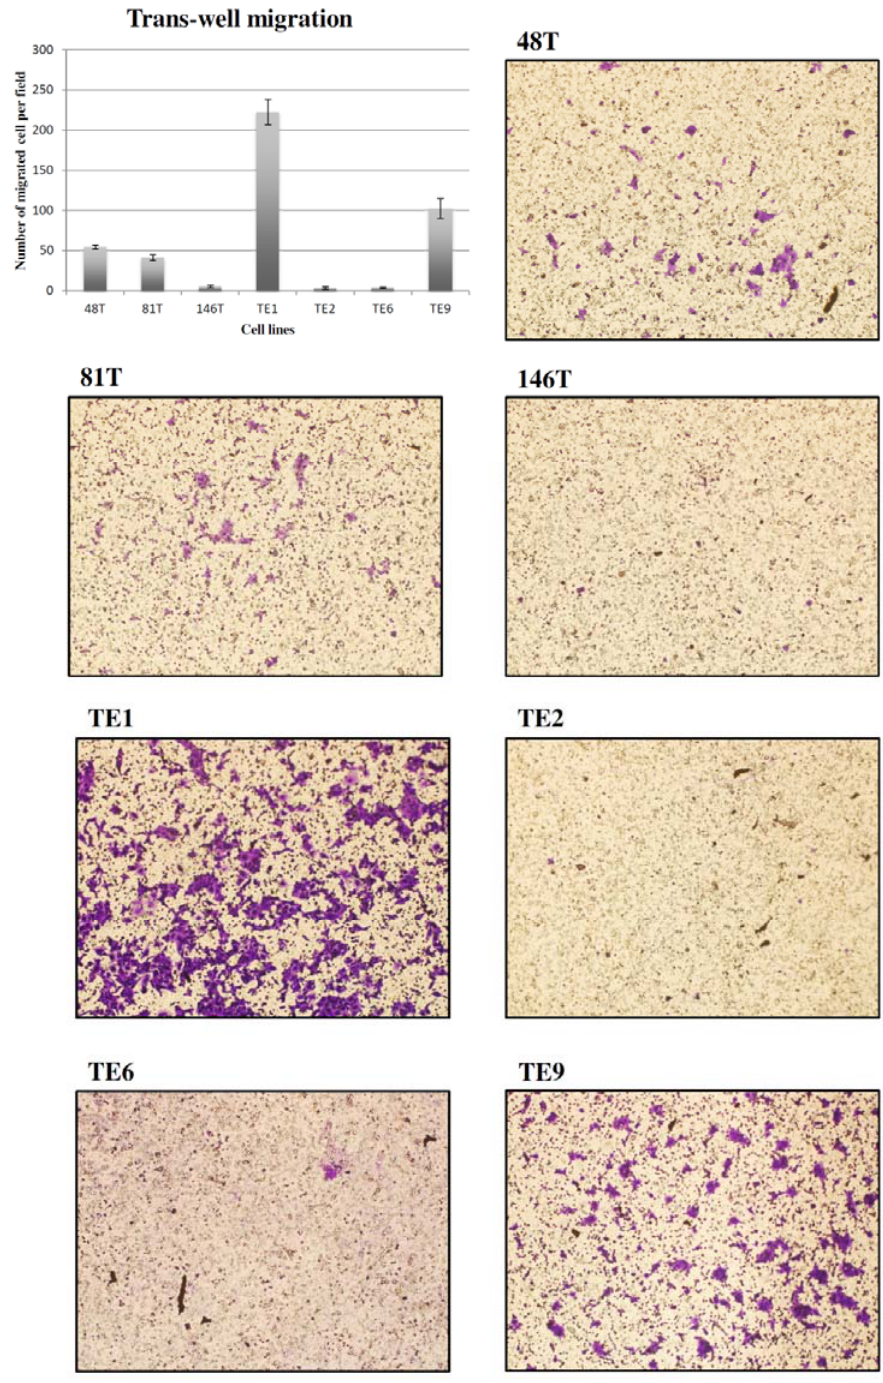
Figure 2. Illustration of the quantitative (bar, cells/field) and photographic (light microscopy) results of the assay of trans-well migration activity among the seven cell lines. TE1 exhibited the highest trans-well migration